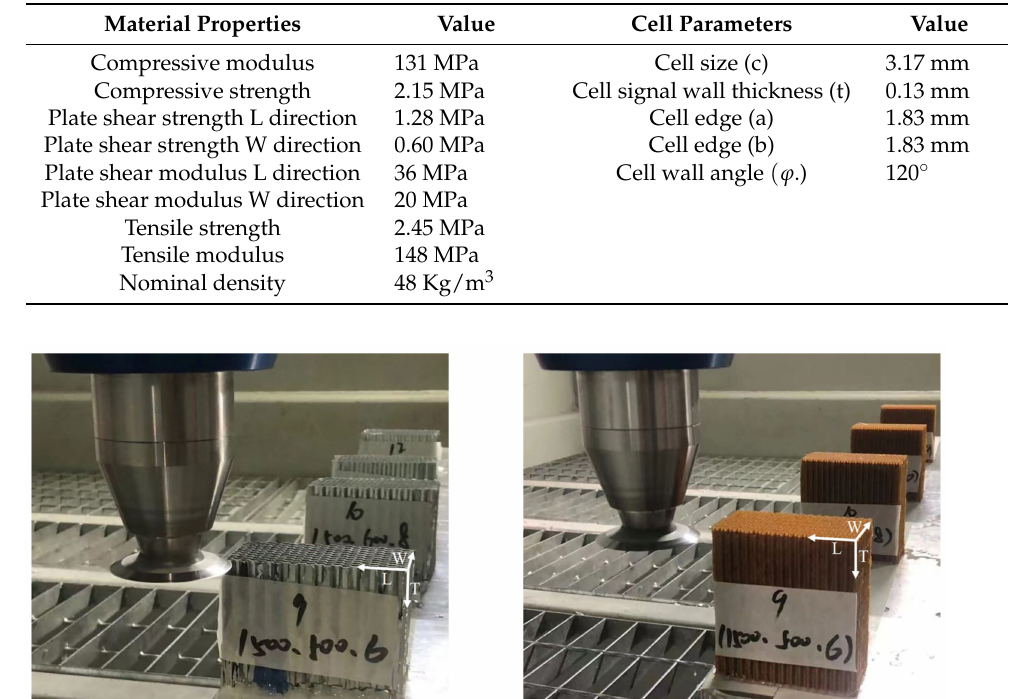
Table 2. Material attributes and cell parameters of Nomex honeycomb core workpiece.